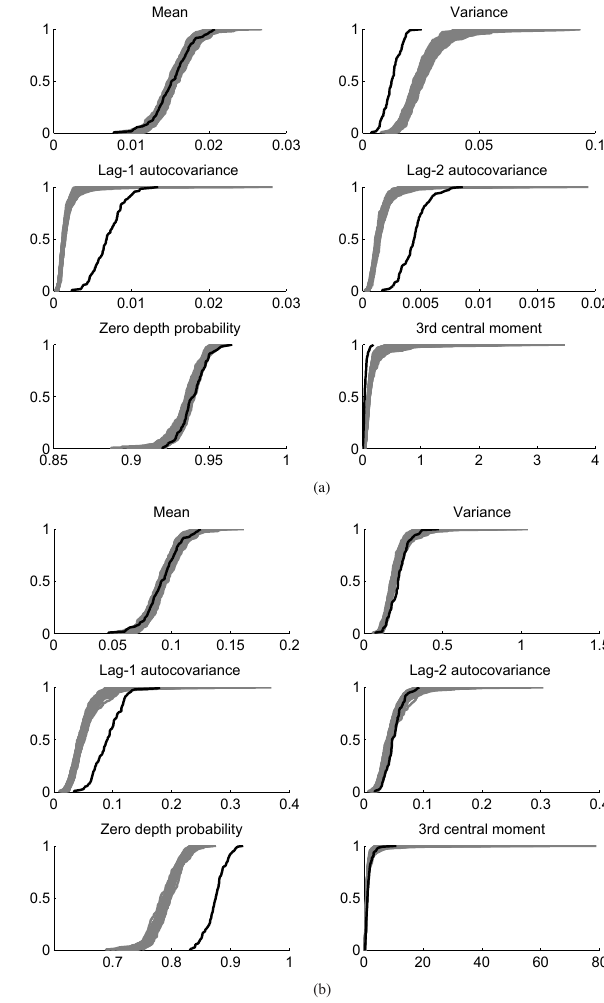
Figure 8. Comparison of the empirical cumulative distributions of the yearly statistics of the observed time series (black line) and the bundle of empirical cumulative distributions of synthetic time series generated by means of the copula-based model (grey) at a 10min (a) and a 1h aggregation level